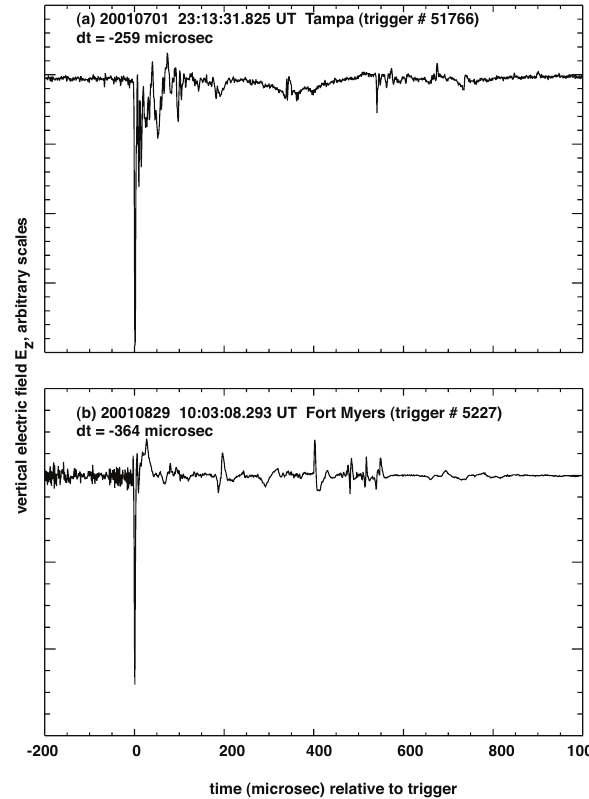
Fig. 6. Similar to Figs. 4 and 5, but for the coincidence in line #7 of Table 2. As in Figs. 4 and 5, the stroke automatically classified as an “NBE” is actually a negative cloud-to-ground stroke.